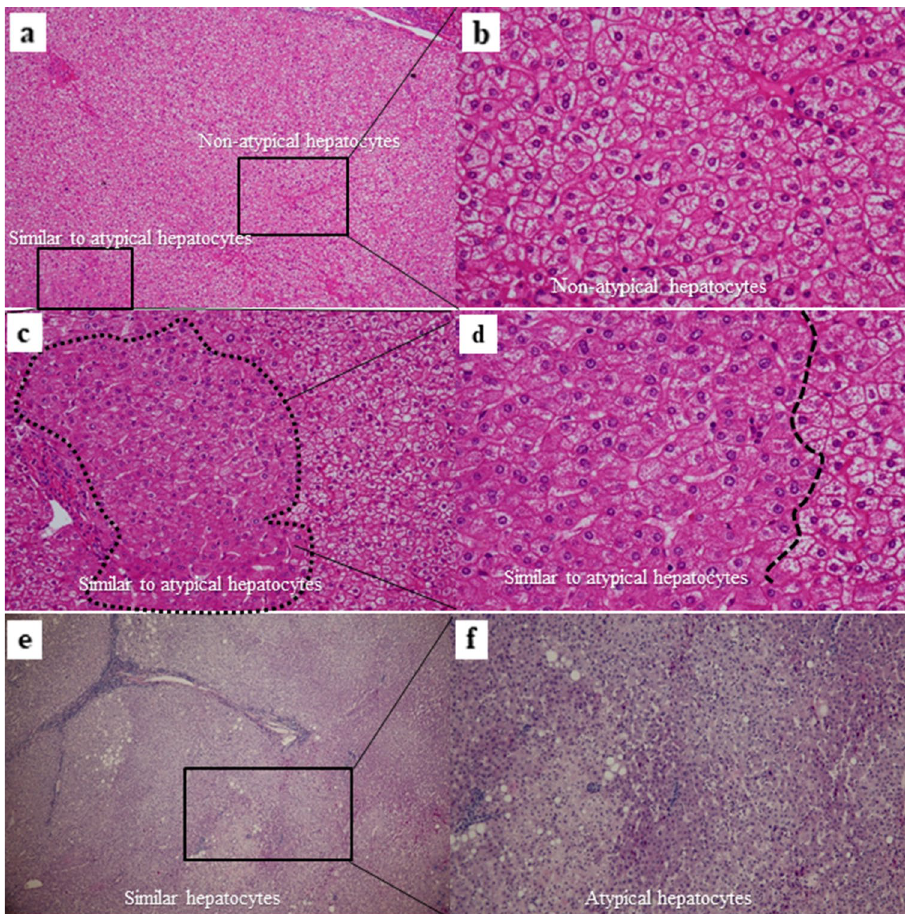
Figure 8. Representative examples (Patients No. 1 and No. 2 in Fig. 7b) of atypical hepatocytes and nonatypical hepatocytes populations in Cohort 5 that were collected by laser capture microdissection (LCM). ( a ) Image represents a lower magnification of a section of patient 1 in Fig. 7b (Hematoxylin and eosin staining (HE), × 40). ( b ) Image represents a higher magnification of a square in a nonatypical hepatocyte population of ( a ) that was morphologically close to usual regenerative hepatocytes (HE, × 200). ( c ) Image represents a square of the hepatocytes population in ( a ) close to the atypical hepatocyte (dashed line; HE, × 100). ( d ) Image represents a higher magnification of the dashed line area in ( c ) (HE, × 200). ( e ) Image represents a lower magnification in patient No. 2 of Fig. 7b (HE, × 40). ( f ) Image represents a higher magnification of a square of ( e ) (HE, ×